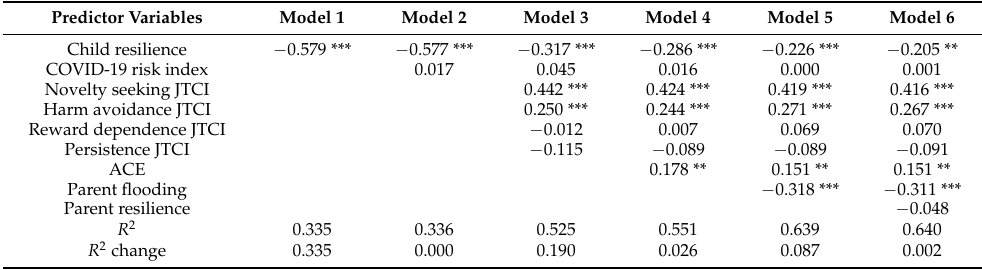
Table 3. Hierarchical regression analysis of predictors of total difficulties SDQ (whole sample).